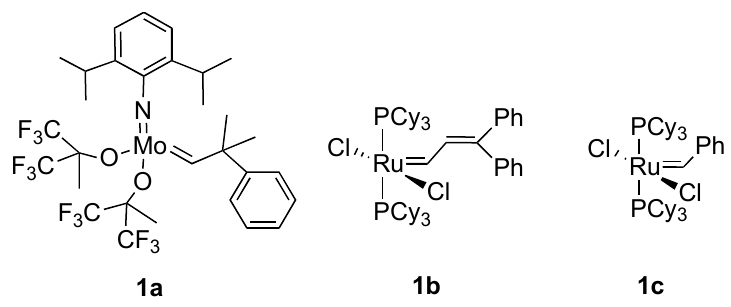
Figure 1. Ruthenium catalysts for alkene metathesis.